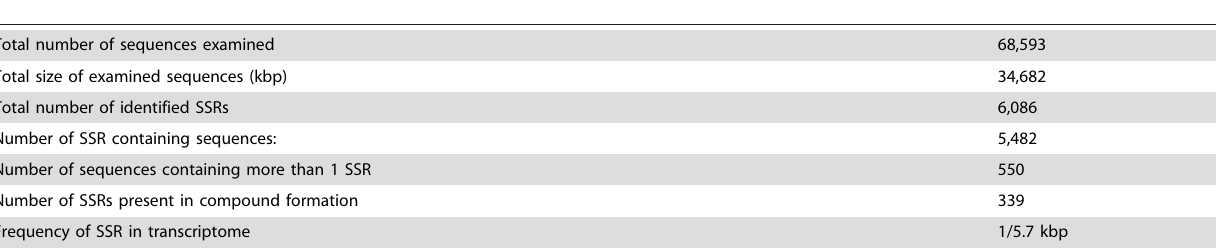
Table 2. Characteristics of SSRs identified in transcriptome